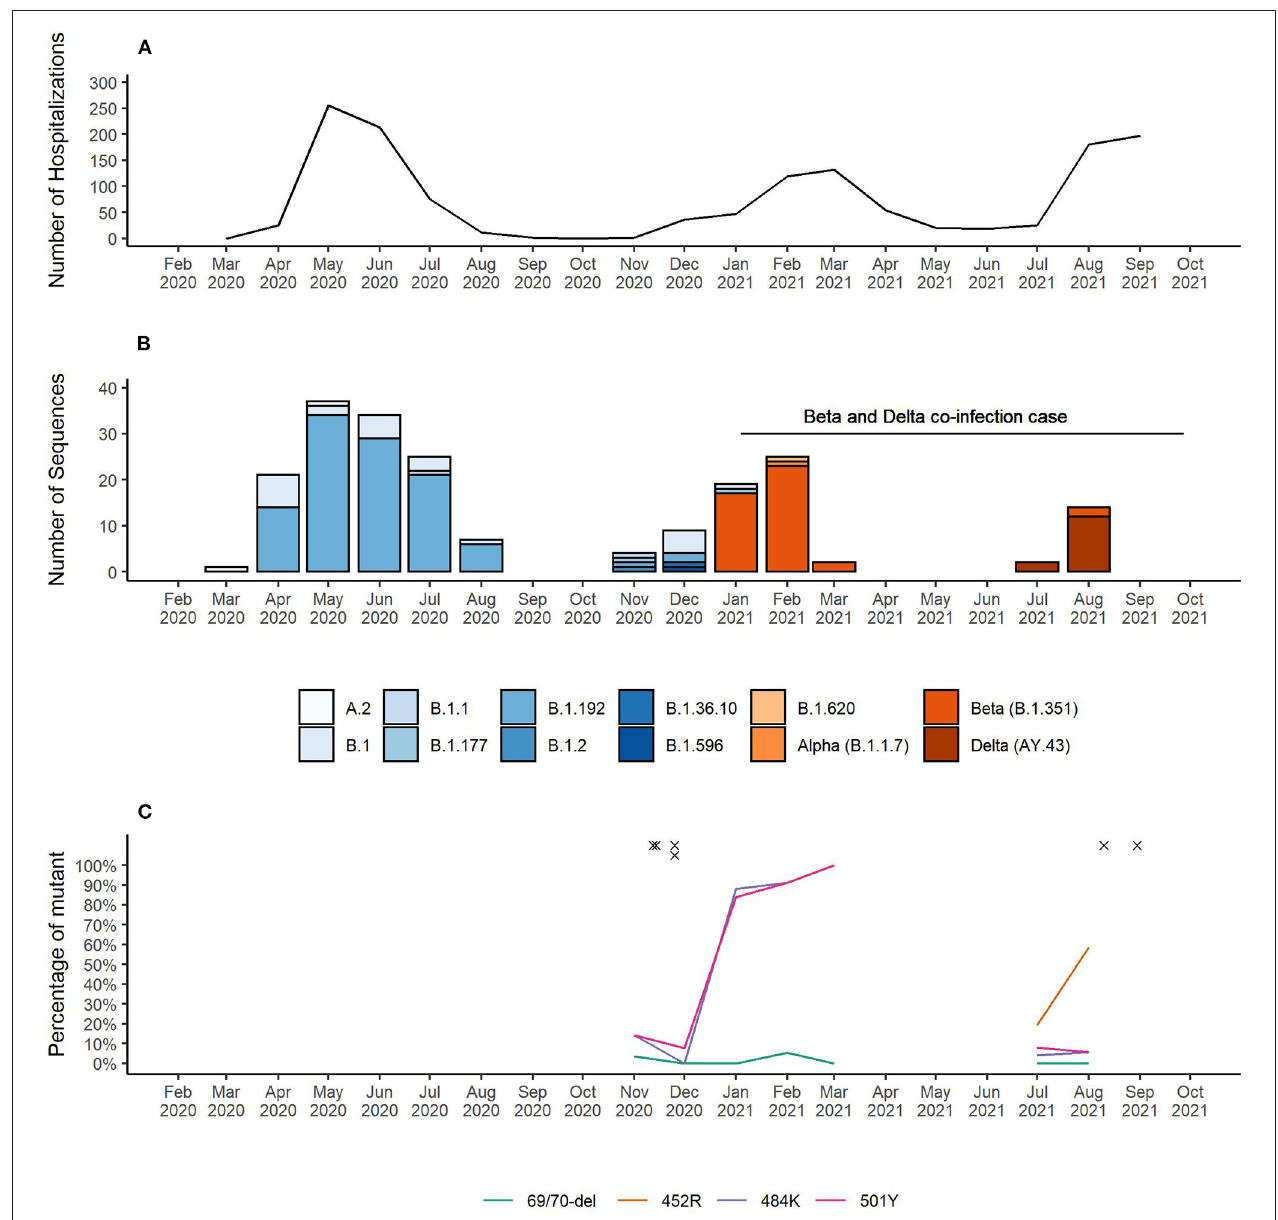
FIGURE 1 | (A) Number of COVID-19 patient hospitalizations per month. (B) SARS-CoV-2 lineages identified in Equatorial Guinea over time. (C) Surveillance of SARS-CoV-2 VOC-associated spike gene mutations. RT-qPCR results for the spike gene mutations L452R, E484K, and N501Y and the spike gene deletion HV69/70 1 indicative of a co-infection are marked with